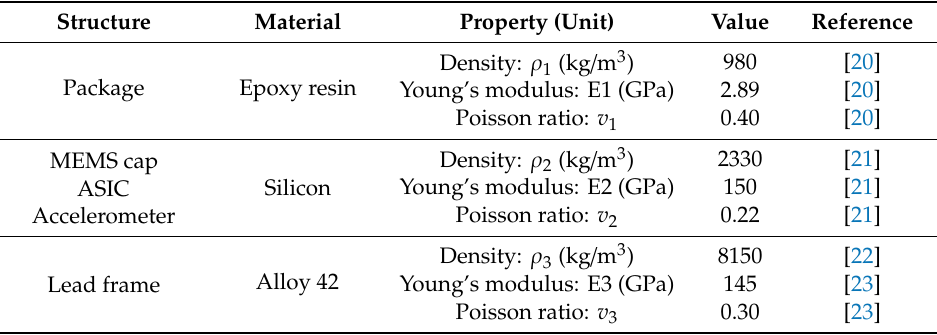
Figure 6. Finite element model of MPU6050. Table 1. Physical properties of MPU6050.